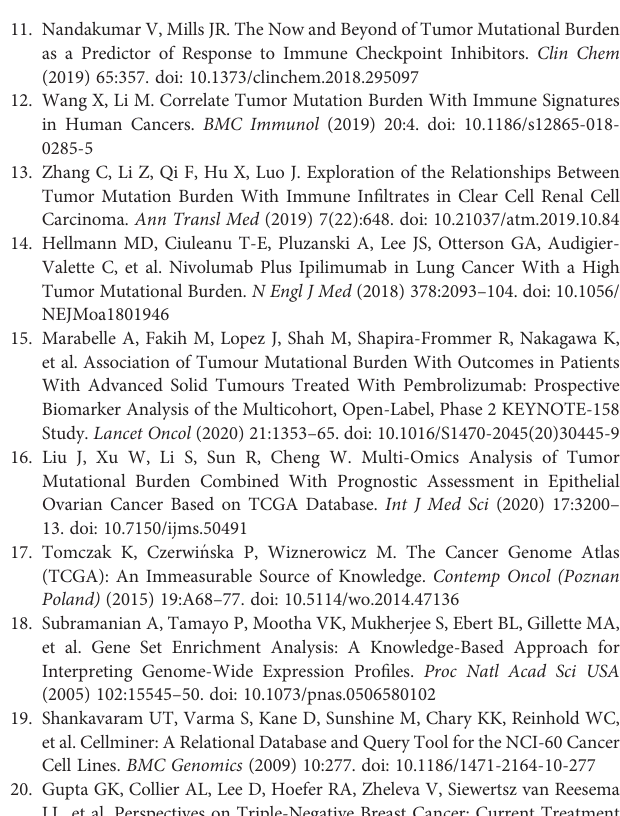
Supplement 1 | Mutations of 8 high mutation rate genes in triple negative breast cancer samples Supplement 2 | The TMB value of each triple negative breast cancer sample and the grouping of the samples. Supplement 3 | Differences in TMB levels of 8 genes between mutant groups and wild groups. Blue represents wild groups, red represents mutant groups, * represents P <0.05, ** represents P <0.01, *** represents P <0.001. Supplement 4 | Evaluation of immune cell abundance in different groups of TNBC samples by CIBERSOFT algorithm. (A) Between the mutant groups and the wild groups (B) Between high and low TMB groups. Different colors represent different immune cell in fi